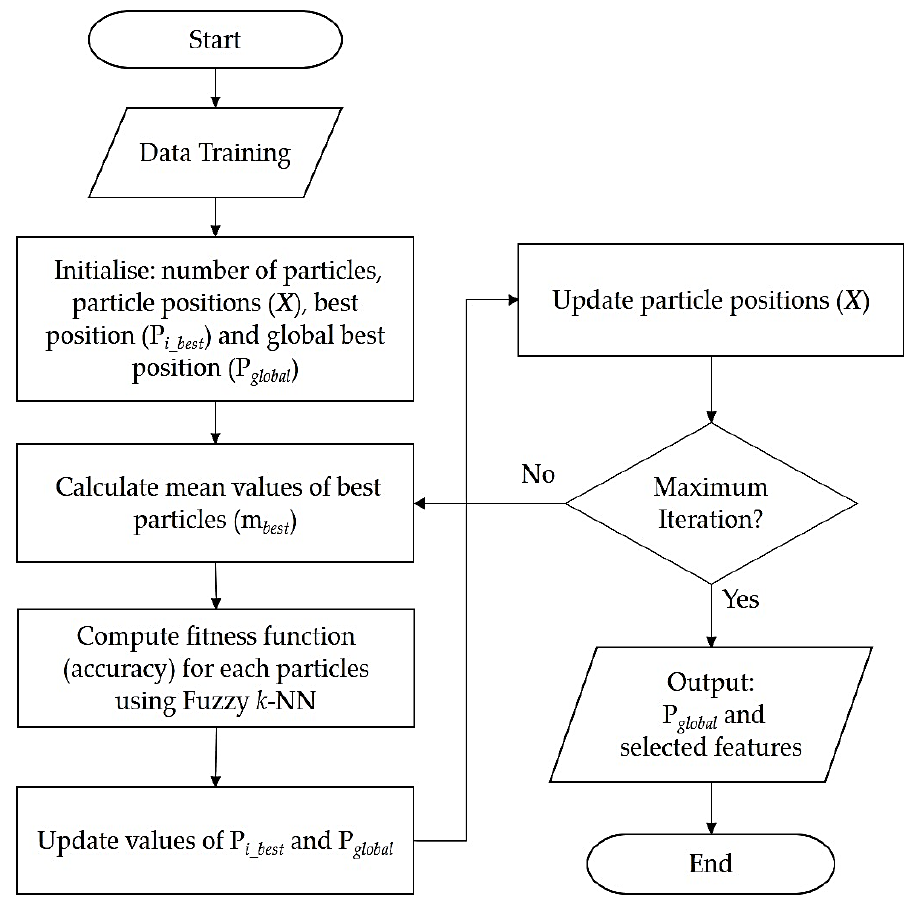
Figure 4. Flowchart depicting process of feature selection using the proposed Q-Fuzzy approach.